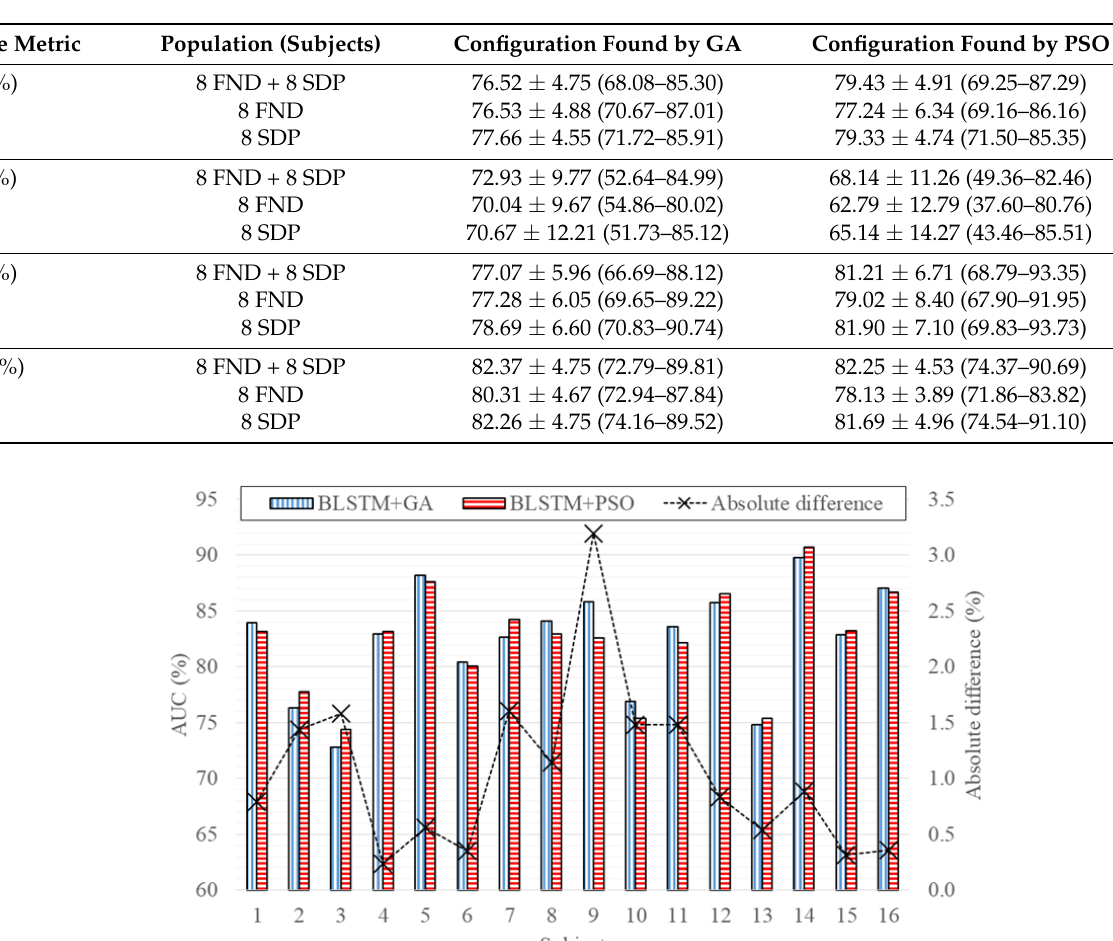
Table 3. Performance attained by the LOO method for the best models identified by the optimization algorithms. Results are presented as “mean ± standard deviation (minimum value–maximum value)”.